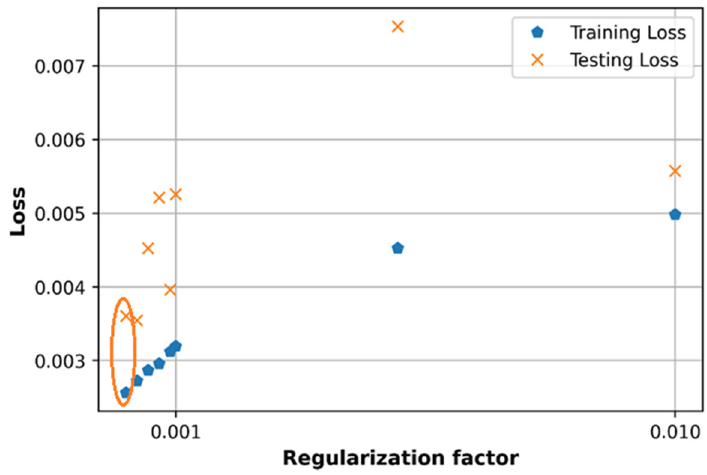
Figure 19. Comparison of loss with different regularization factor.